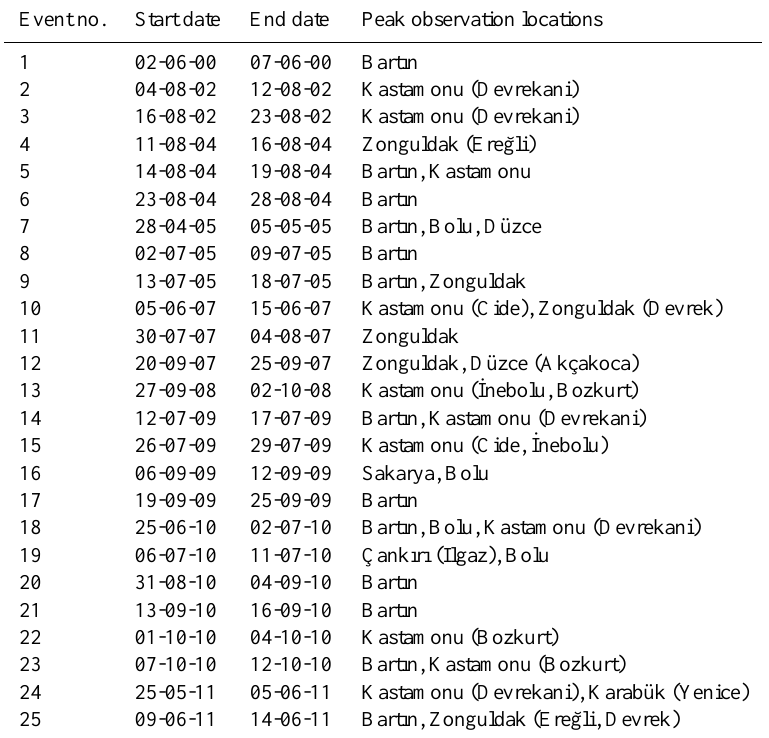
Fig. 1. The study area with WRF model configuration of two nested domains at 12km and 4km resolutions is shown in (a) and the detailed view of 4km domain with the locations of rain gauge stations used in comparison as well as the border of city provinces in the region are shown in (b) . Numbers 1 and 2, located at the center point of coarse- and fine-resolution domains, identify 12km and 4km domains, respectively. Table 1. Studied events and their occurrence periods with the rainfall peak locations are given. Event no. Start date End date Peak observation